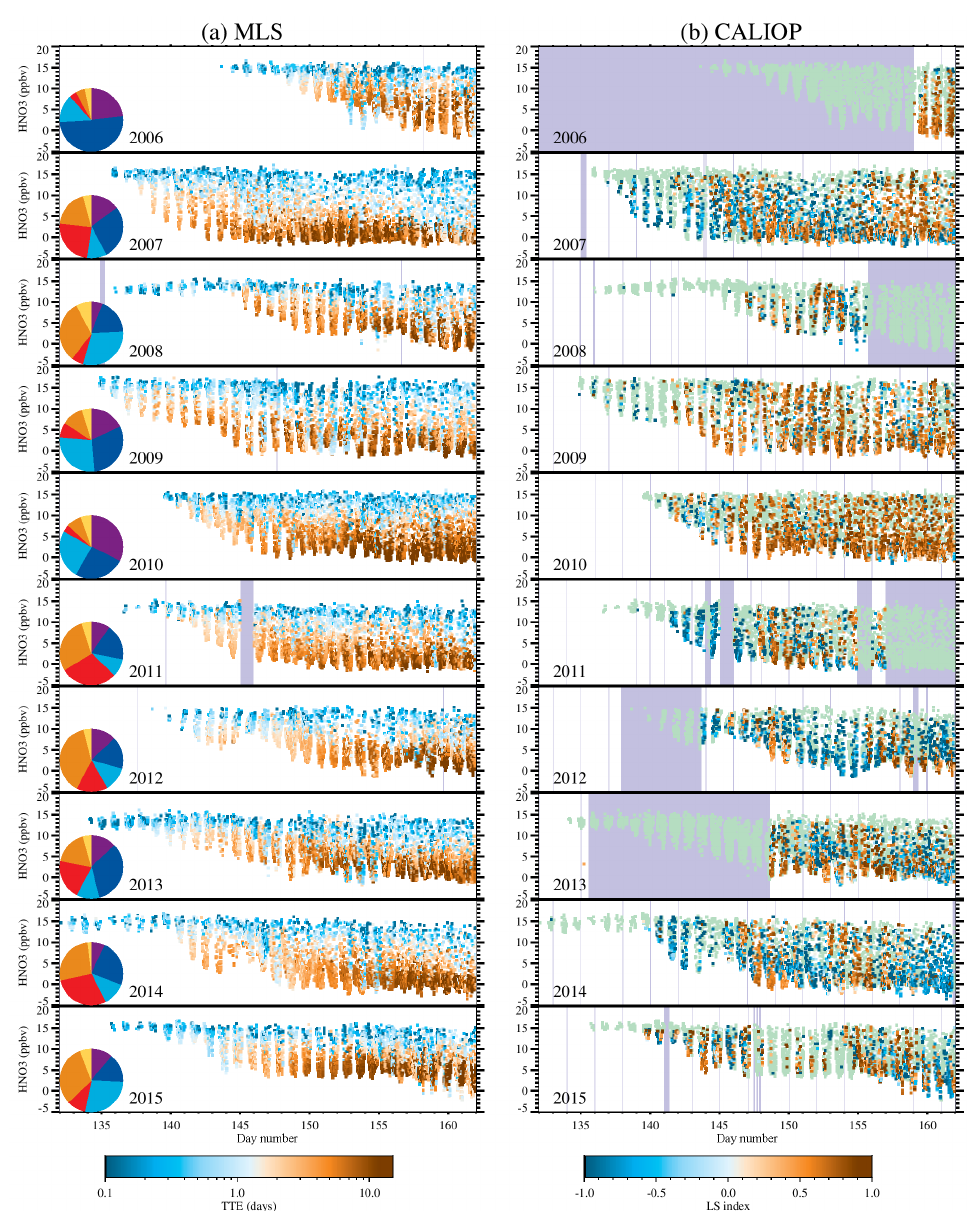
Figure 15. Time series for the Antarctic for associated HNO 3 and PSCs during 2006–2015 at 32hPa. (a) MLS HNO 3 vs. day number. The color scale shows the TTE. Only data for TTE > 0.1 day are plotted. The inset pie charts indicate the relative proportions of measurements in six categories (red–yellow sectors are solid PSCs; purple–blue sectors are liquid PSCs) as defined in the text and in Fig. 16. (b) CALIOP LS_index vs. day number. The color scale shows the LS_index . Gray shading indicates no measurements. Light green shading in (b) indicates the envelope of MLS HNO 3 observations in (a)